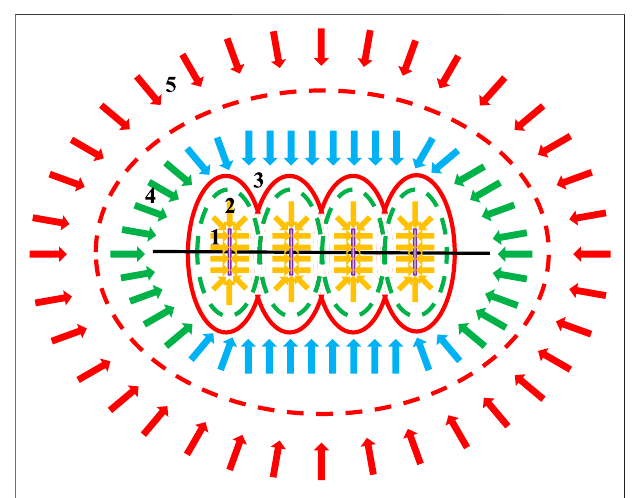
FIGURE 1 | Sectional fracturing fl ow of shale gas horizontal